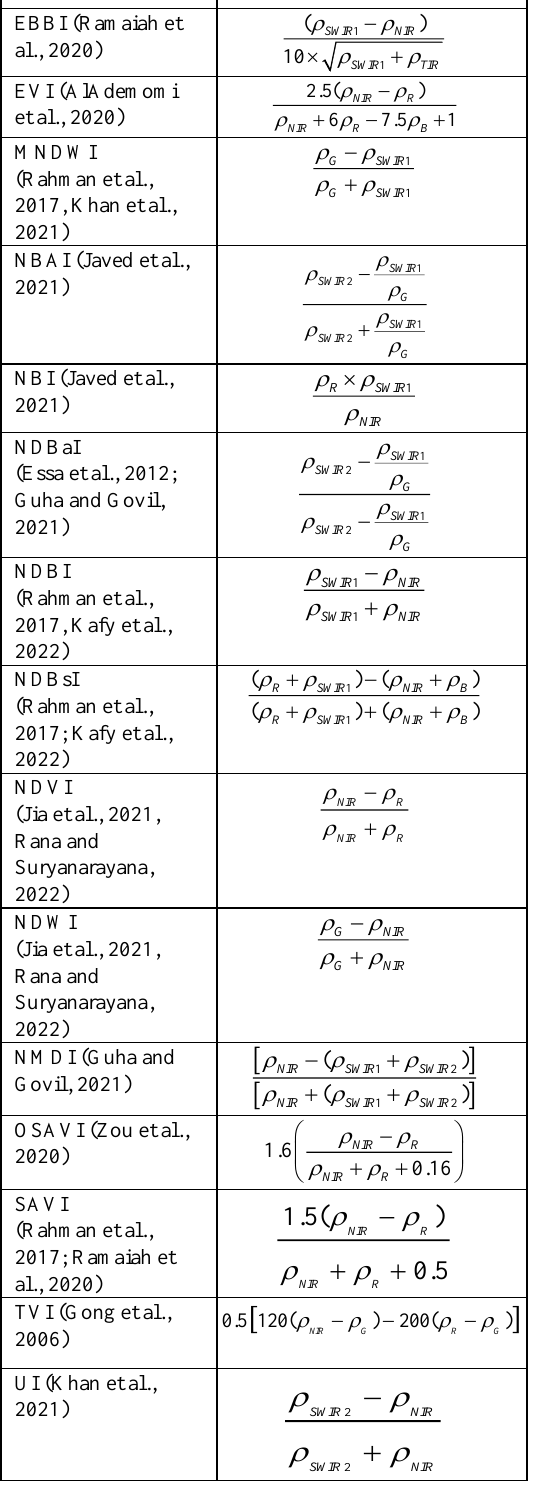
 , are respectively, B the blue, green, red, near infrared, short wavelength infrared 1, and short wavelength 2 bands of Landsat 8.